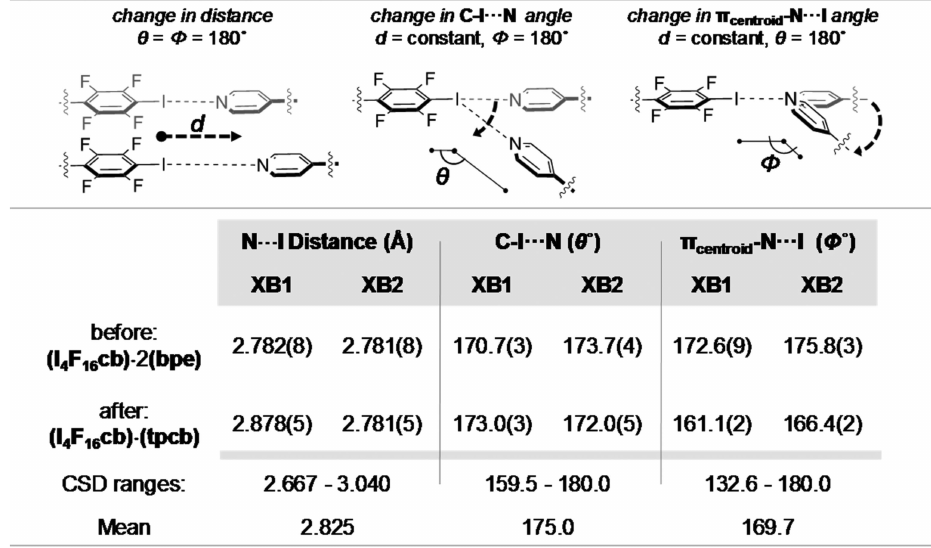
Figure 2 Table of halogen-bond metrics and changes in the geometries of components of (I 4 F 16 cb) (cid:2) 2(bpe) and (I 4 F 16 cb) (cid:2) (tpcb) with comparisons to the